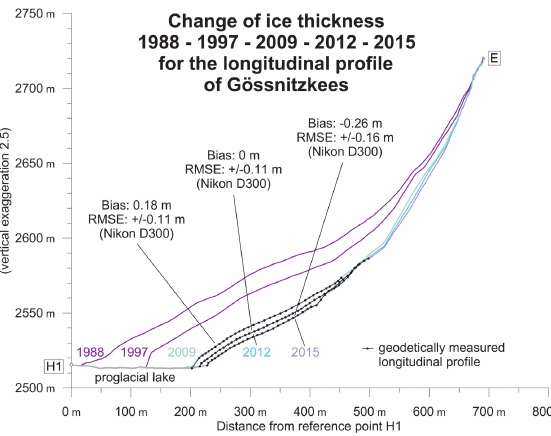
Figure 7. Terrestrial photogrammetric documentation of change in ice thickness of Gössnitzkees for the period